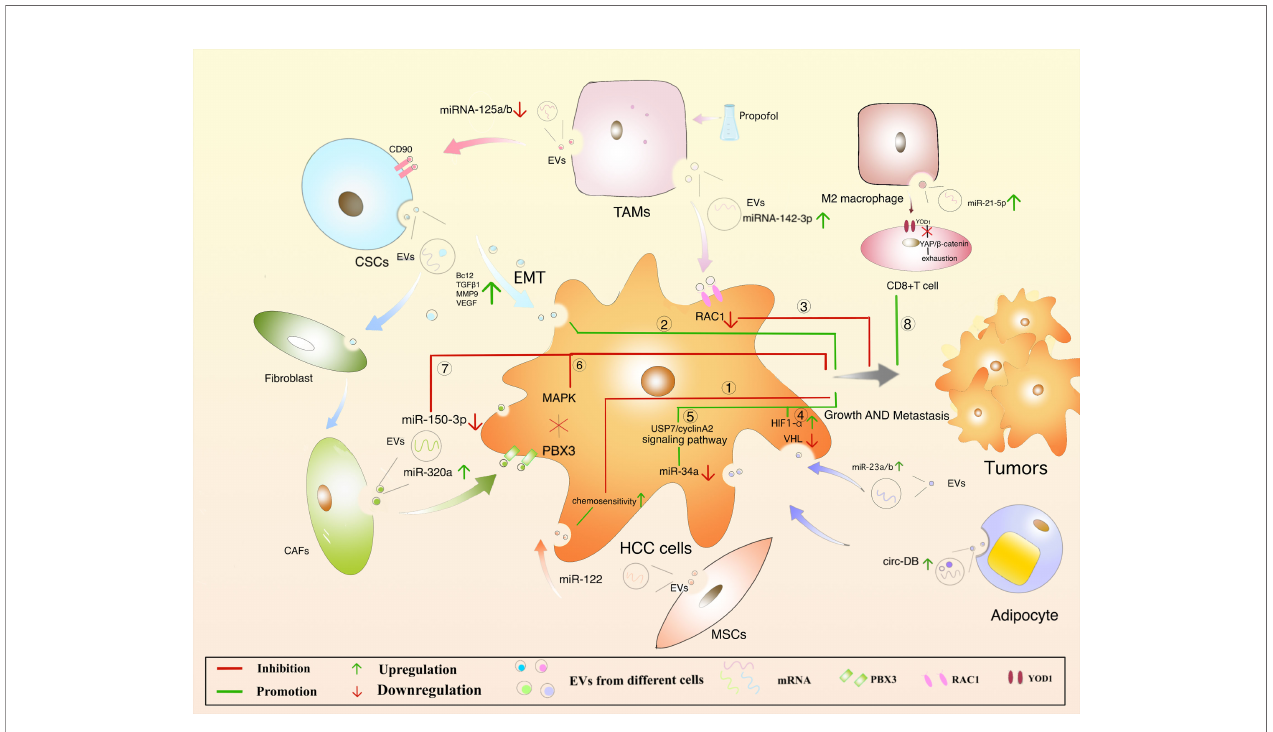
FIGURE 4 | Regulation of HCC by different cell-derived